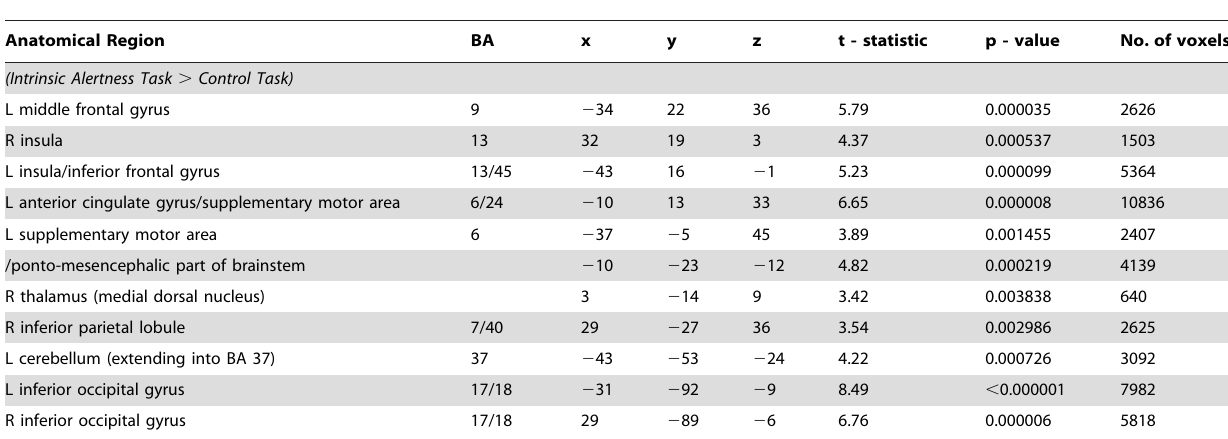
Table 1. List of fMRI activations for the contrast Intrinsic Alertness Task . Control Task.